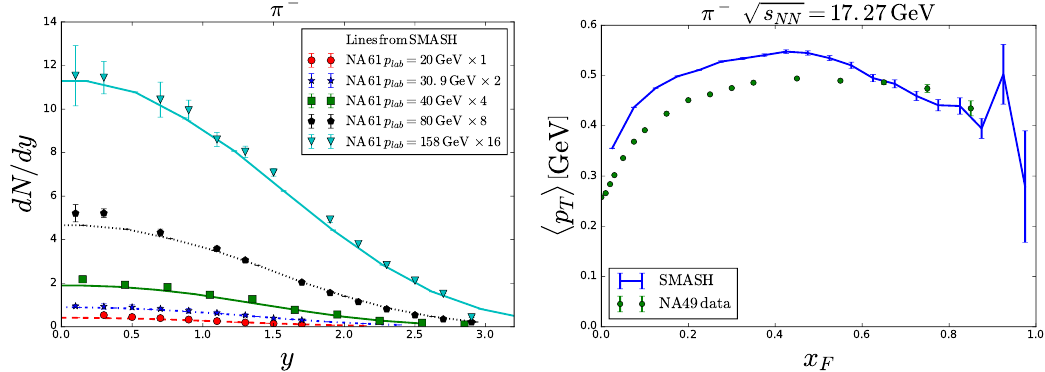
Figure 1. Rapidity spectra of negatively charged pions in proton-proton collisions at different energies compared to experimental data [8] on the left hand side and the mean transverse momentum of negatively charged pions in proton-proton collisions at data [9] on the right hand